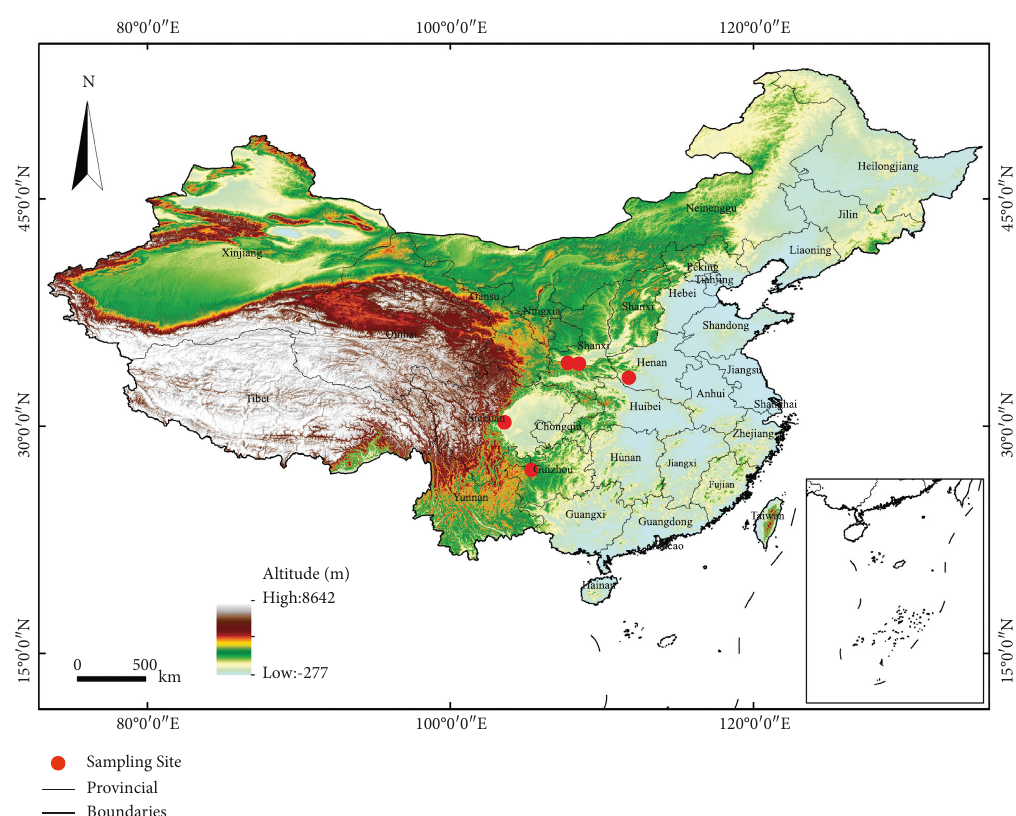
Figure 1: Distribution map of kiwifruit sample collection